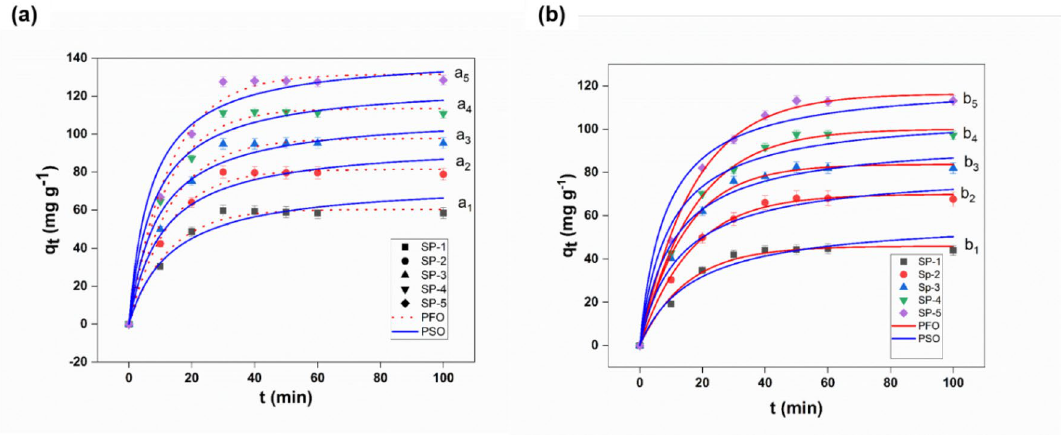
Figure 6. Kinetic curves onto SP-1, and SP-2, 3, 4, 5 ENMs; [Metal (Csubs0) = 0.2 mg L −1 , at pH-7, 220 rpm for